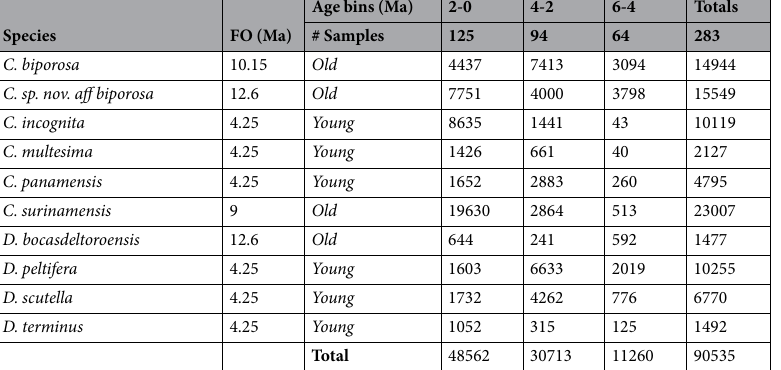
Table 1. Numbers of colonies of the 10 commonest cupuladriid species used in this study in samples over three time-bins. First occurrences (FO) of species is also listed and the number of samples per time bin. Total colonies analysed = 90,535. Total samples = 283 (195 fossil and 88 Recent). Note 0–2 Ma time bin includes 88 Recent dredge and 37 fossil bulk samples. FO’s derived from O’Dea and Jackson 52 .